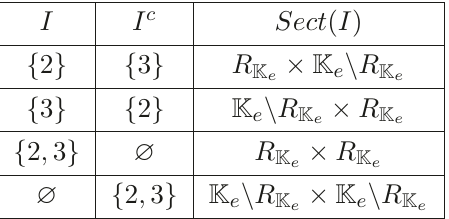
Table 1 . In the table we enumerate the different subsets I , their complements T r I and their associated region Sect ( I